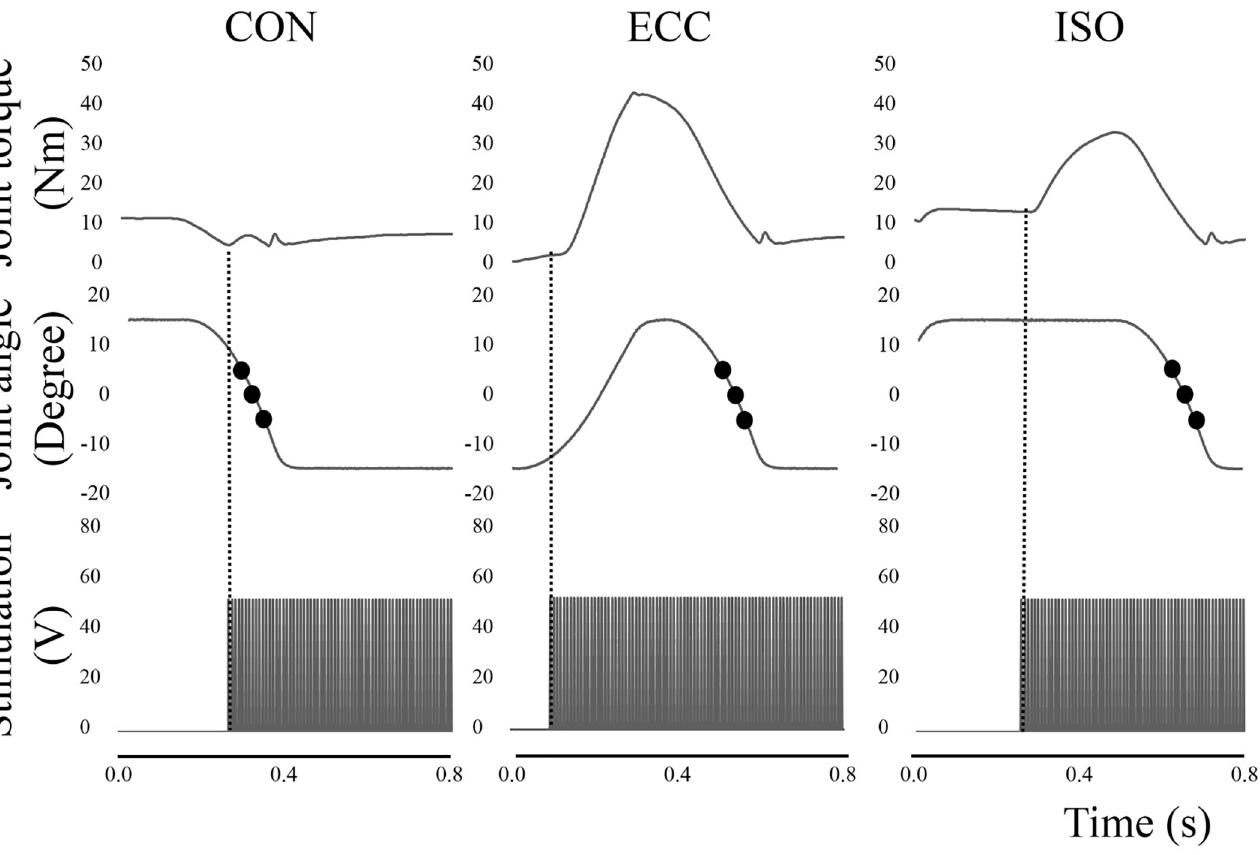
Fig 2. Time course changes in joint torque, joint angle, and timing of electrical stimulation in three contraction conditions. The vertical dotted line shows the onset of electrical stimulation. The filled circles show the timing of joint toque measurement (DF5°, PF0°, and PF5°, respectively). CON; concentric contraction without preliminary contraction, ECC; concentric contraction after preliminary eccentric contraction, ISO; concentric contraction after preliminary isometric contraction, DF; dorsiflexion, PF; plantarflexion.